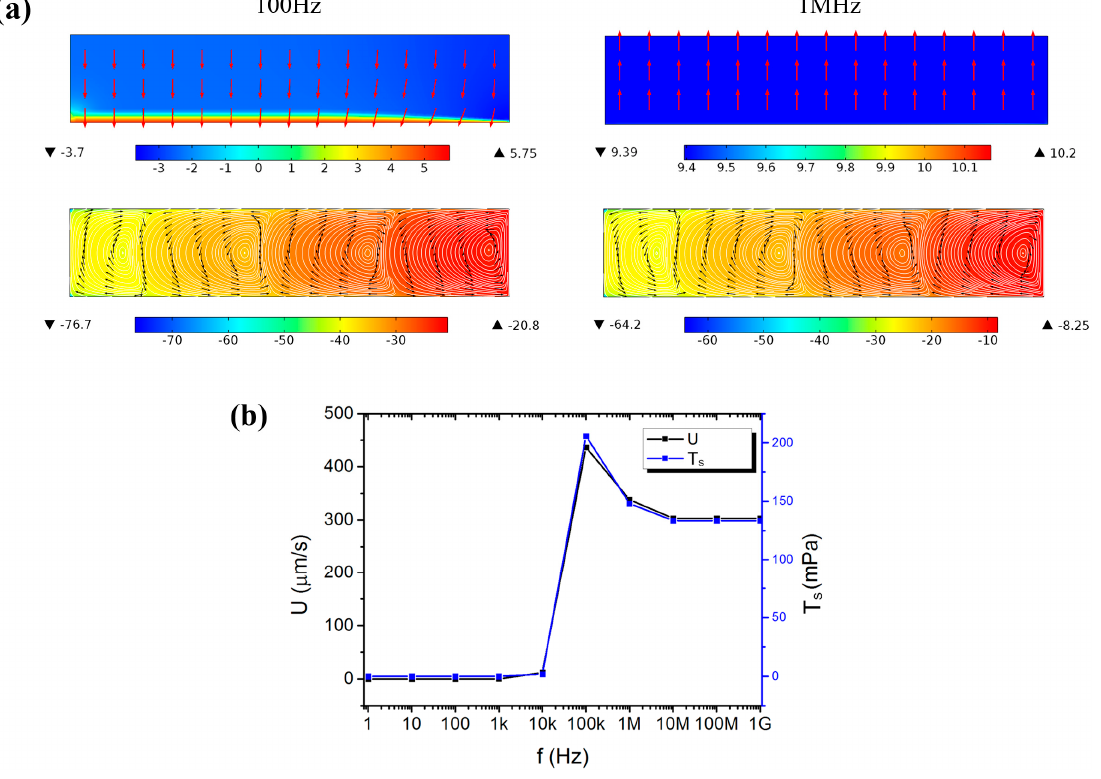
Figure 7. Numerical results of the 3D electrode system. ( a ) The electric field and the formed EOF in a vertical section at 100 Hz and 1 MHz, respectively. The surface plot used a logarithmic scale. ( b ) The frequency-dependent maximum value of the velocity amplitude ( U ) and the load (T s ) the lipid film experienced from the ACEO.